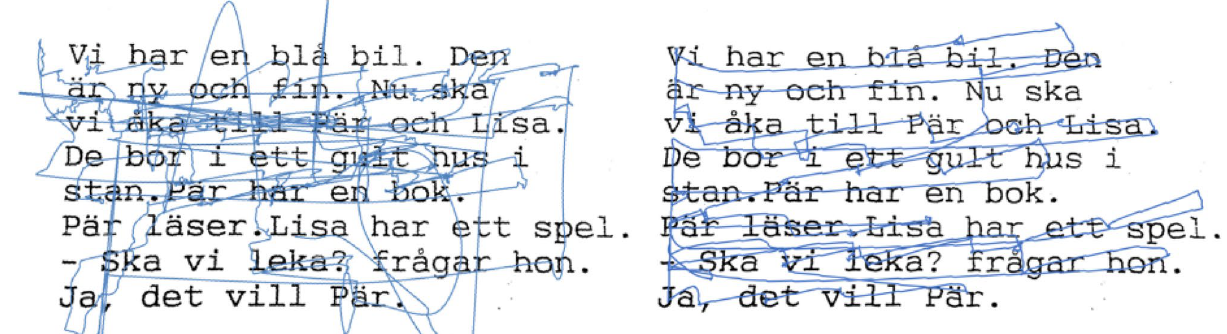
Figure 1. Eye movements of randomly selected subjects from the high risk (left) and low risk (right) dyslexia groups during a text reading test (movements outside the paper are not shown because of spatial